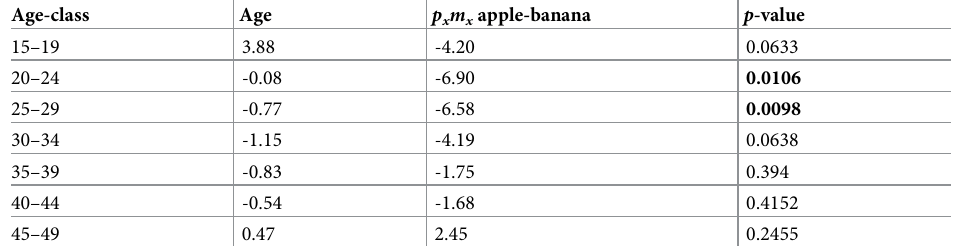
Table 3. Estimates of p intercepts for each age-class (days from egg) in the CO populations on the banana and x m x apple diets and p -value of their statistical comparison.